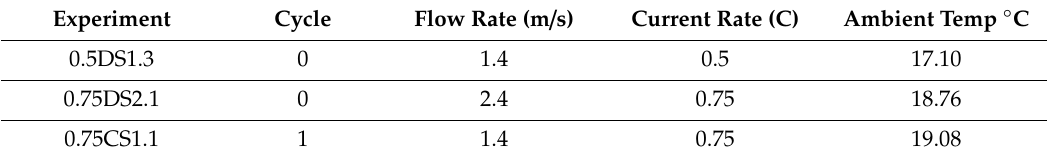
Table 6. Artificial Neural Network (ANN) Input Training Data Sample.